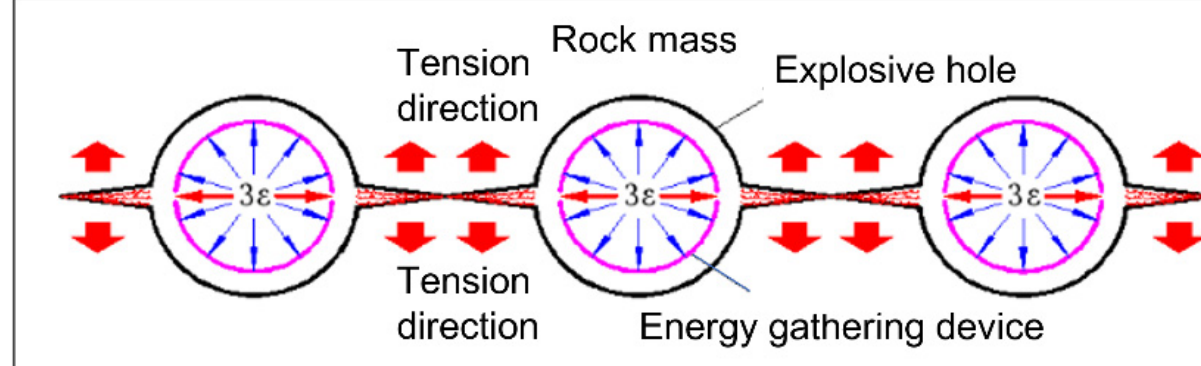
Figure 9. Principle of concentrated energy blasting technology.